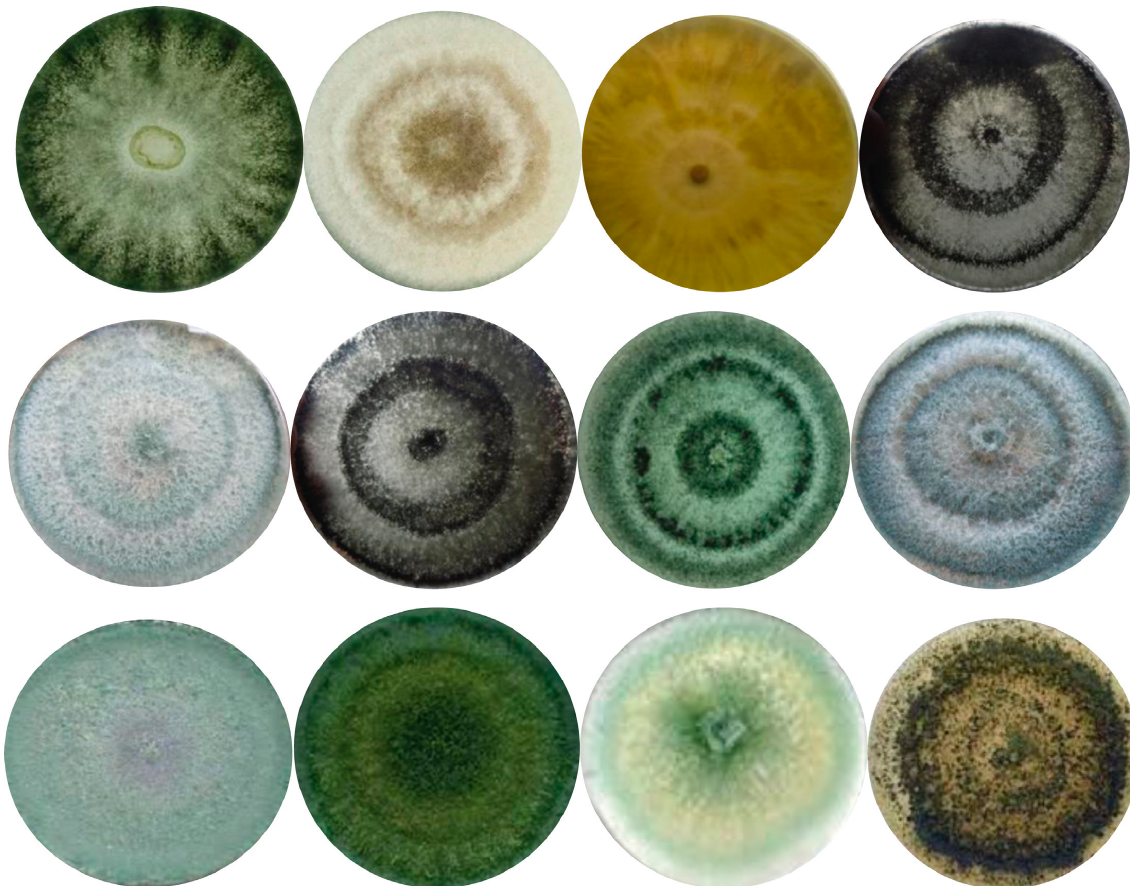
Figure 1: Colony morphology of representative Trichoderma isolates grown on PDA.